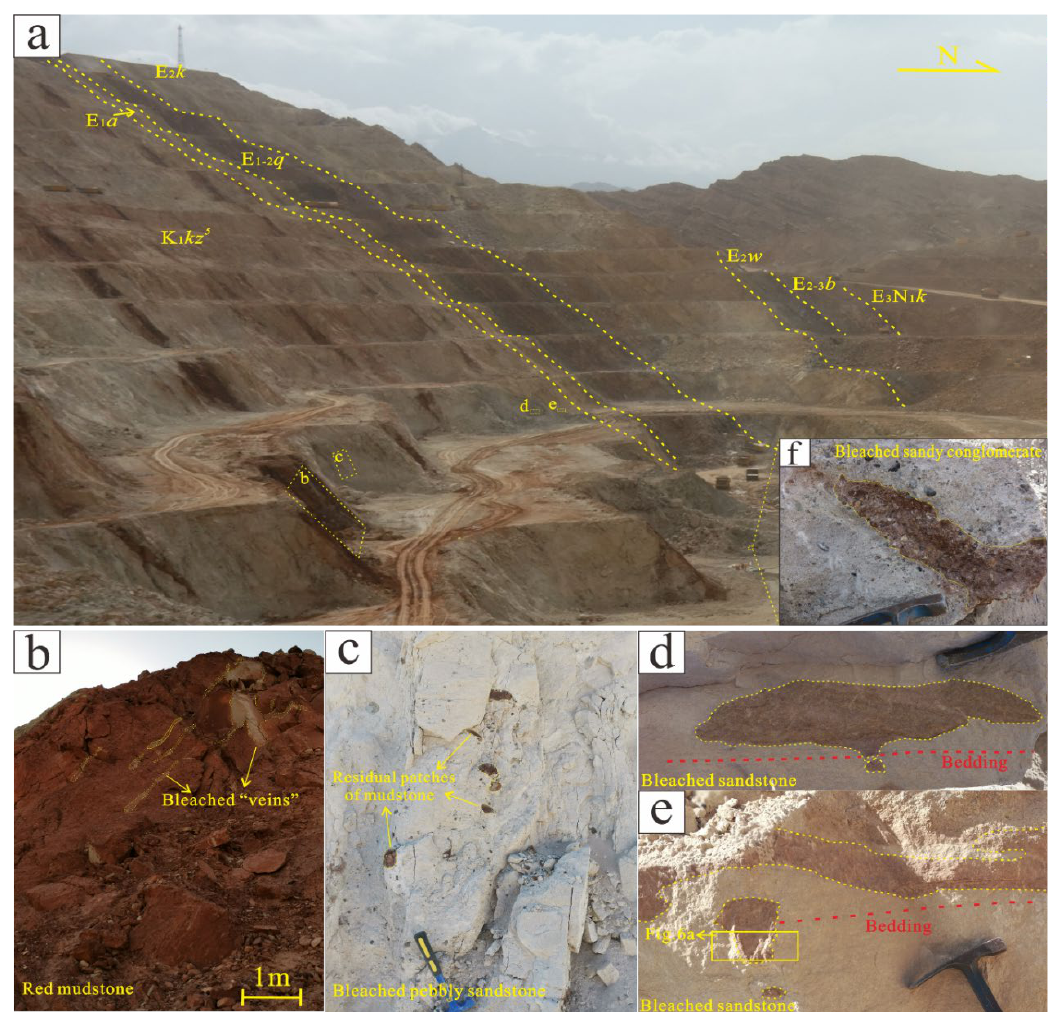
Figure 5. Photographs of the bleaching phenomenon from the fifth member of the Lower Cretaceous Kezilesu Group in the Uragen Zn–Pb deposit. ( a ) Field photographs of outcropping formations in the west slope of the open pit in the southern ore zone. ( b ) Red mudstone interbed crosscut locally by the bleached veins. ( c ) Residual patches of red mudstone in bleached pebbly sandstone. ( d , e ) Residual patches of red sandstones in the bleached sandstone and sedimentary bedding crosscut by the bleached zones. ( f ) Residual patches of red sandy conglomerate in the bleached sandy conglom- erate. The location of sample WG-18 in Figure 6a has been outlined. Lithostratigraphic abbrevia- tions: K 1 kz 5 , fifth member of Kezilesu Group, Lower Cretaceous; E 1 a, Aertashi Formation, Paleo- cene; E 1-2 q, Qimugen Formation, Paleocene–Eocene; E 2 k, Kalataer Formation, Eocene; E 2 w, Uragen Formation, Eocene; E 2-3 b, Bashibulake Formation, Oligocene-Eocene; E 3 N 1 k, Keziluoyi Formation, Miocene–Oligocene. 3. Samples and Analytical Methods Thirty-two red and bleached sandstone samples were collected from the south ore zone in the Uragen Zn–Pb deposit and were made into polished thin sections for detailed petrographic observations. Zeiss Axioscan 7 fully automatic petrographic analysis micro- scope was also employed for fluorescence observation using X-Cite Xylis LT720L fluores- cence light source, wavelength of 455 nm and intensity of 15%. Of all these samples, WG- 18 sample from the slightly mineralized zone at 2104 m level in the west slope of the open pit were selected (Figure 5e), and the red and bleached sandstone at the same sedimentary layer (Figure 6a) was then prepared for petrography, TIMA and μ-XRF studies. Eight powder samples were also obtained from the WG-18 sample using the micro-drilling tech- nology for whole-rock geochemistry analysis and mass balance calculation (Figure 6a). In